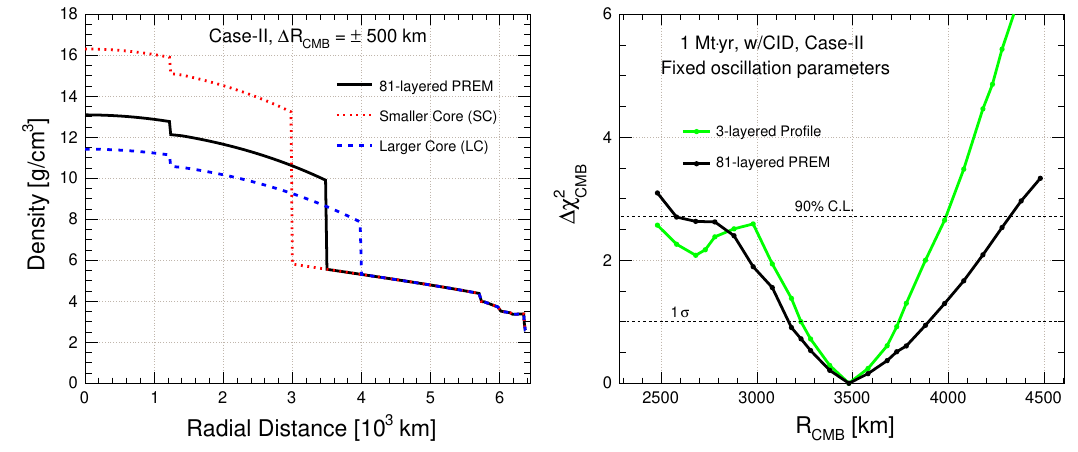
Figure 11 . The left panel shows densities as functions of radial distance for modified R CMB in the 81-layered PREM profile for Case-II. The black curve shows the standard density profile with R CMB = 3480 km. The dotted-red (dashed-blue) curve indicates the density profile in the SC (LC) scenario, where R is decreased (increased) by 500 km. The right panel shows the median CMB ∆ χ 2 sensitivities as functions of the location of R for Case-II. The green and black curves CMB CMB correspond to the sensitivities for the simple three-layered profile and the 81-layered PREM profile, respectively. All the oscillation parameters are kept fixed while evaluating ∆ χ 2 . The sensitivities CMB correspond to 1 Mt · yr exposure where the charge identification capability of ICAL has been used. For simulating the MC data, we use three-flavor neutrino oscillation parameters given in table 2, where we assume NO and sin 2 θ = 23